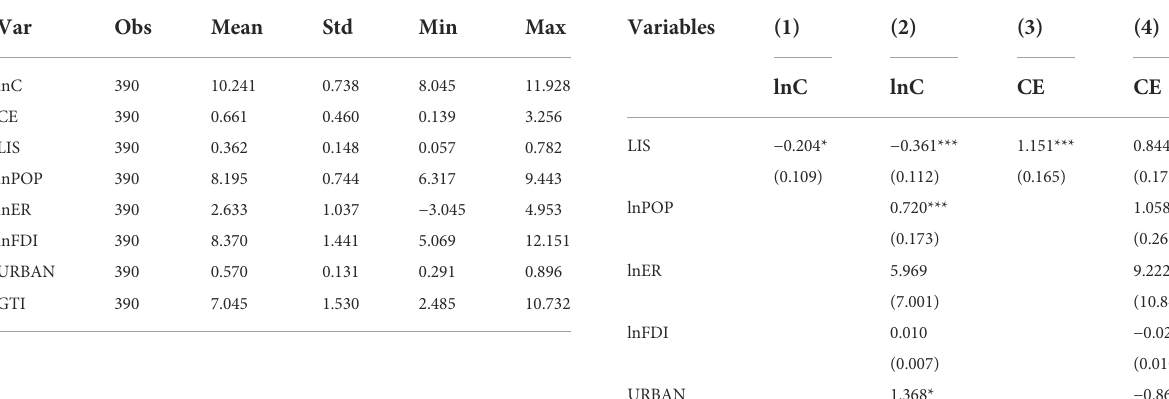
TABLE 3 Variables de fi nitions. TABLE 4 Baseline regression